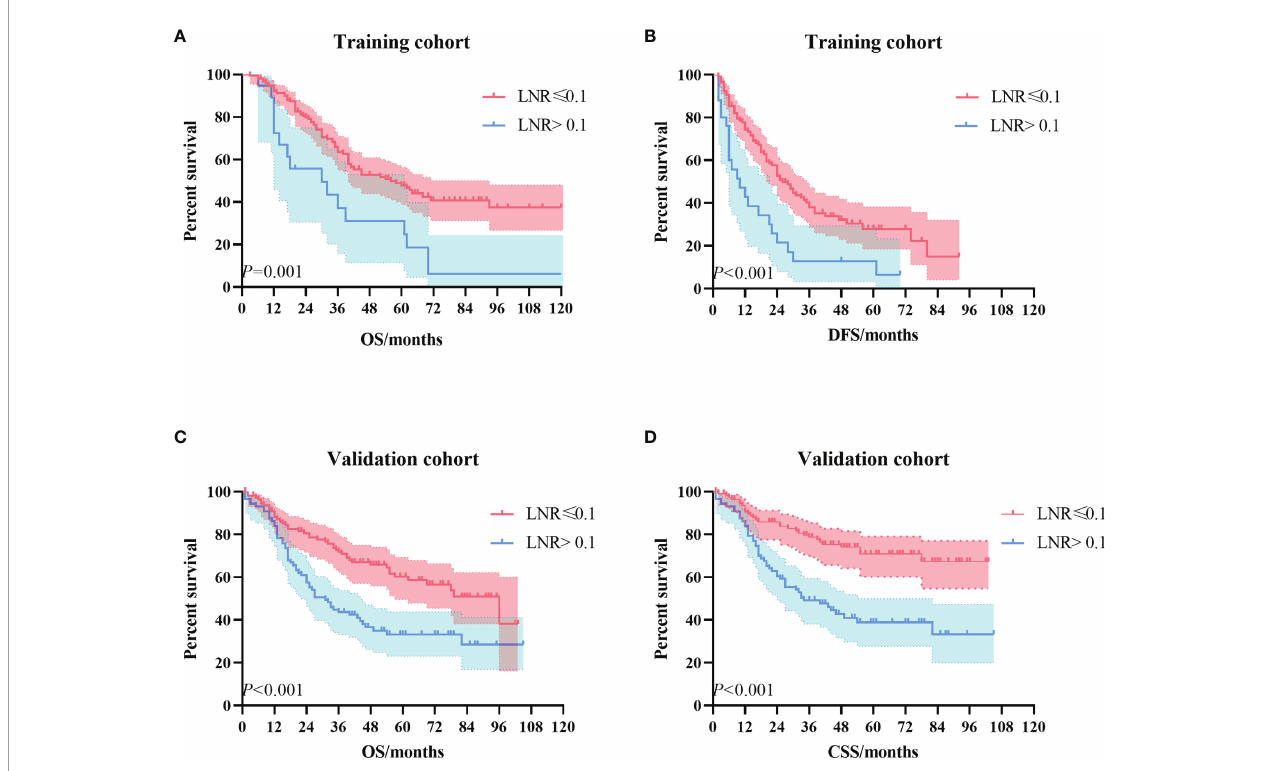
FIGURE 4 | The Kaplan – Meier survival curves according to the LNR stage. (A) OS curve in the training cohort. (B) DFS curve in the training cohort. (C) OS curve in the validation cohort. (D) CSS curve in the validation cohort. LNR, lymph node ratio; OS, overall survival; DFS, disease-free survival; CSS, cancer-speci fi c